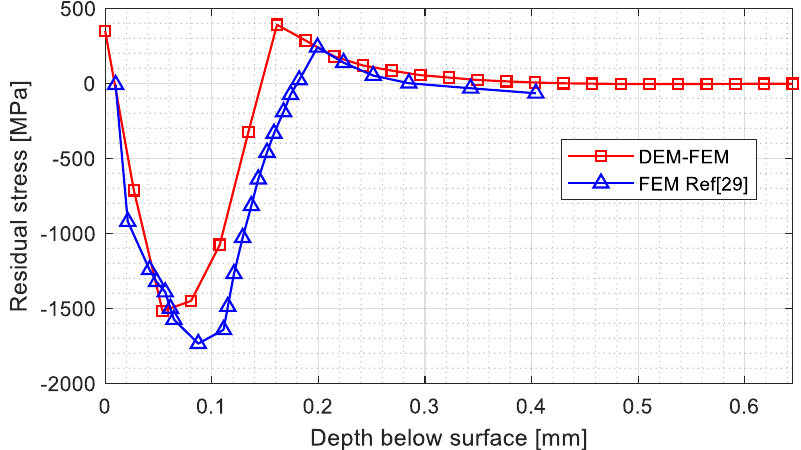
Figure 7. Residual stress profile for a single shot of 0.3556 mm diameter at 70 m/s onto a target made of Inco718. Showing the current DEM-FEM result and FEM result recreated from the literature [29].